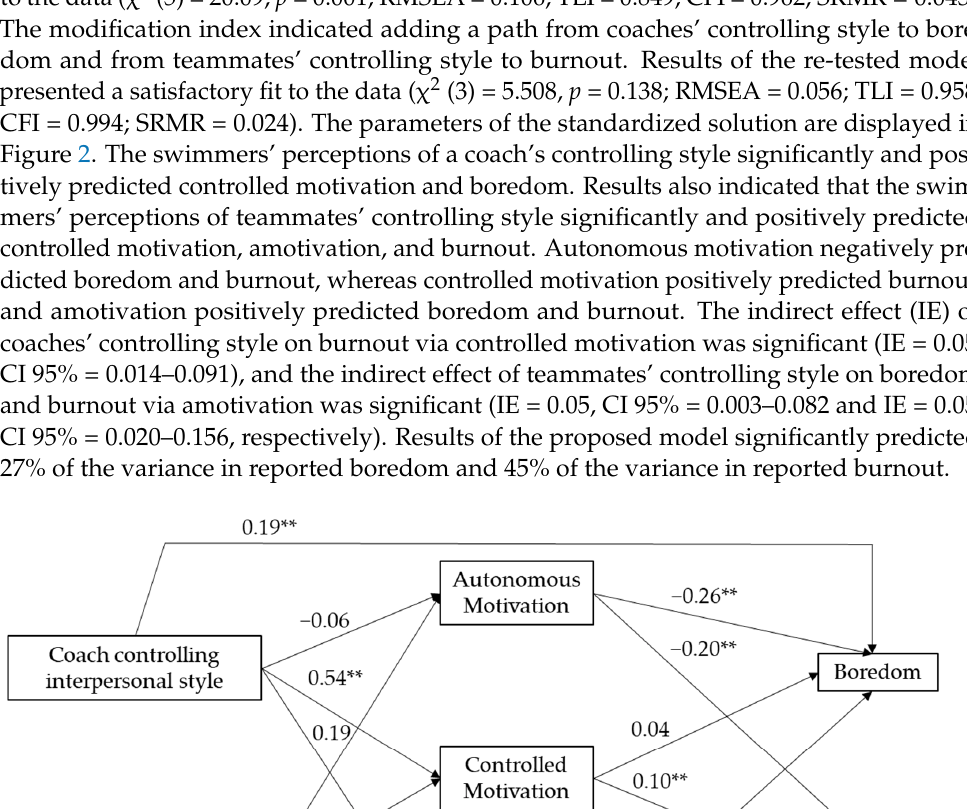
Figure 2. Unstandardized solution of the relationship between coaches’ and teammates’ control- ling interpersonal style, forms of motivation, boredom, and burnout. * p < 0.05; ** p <